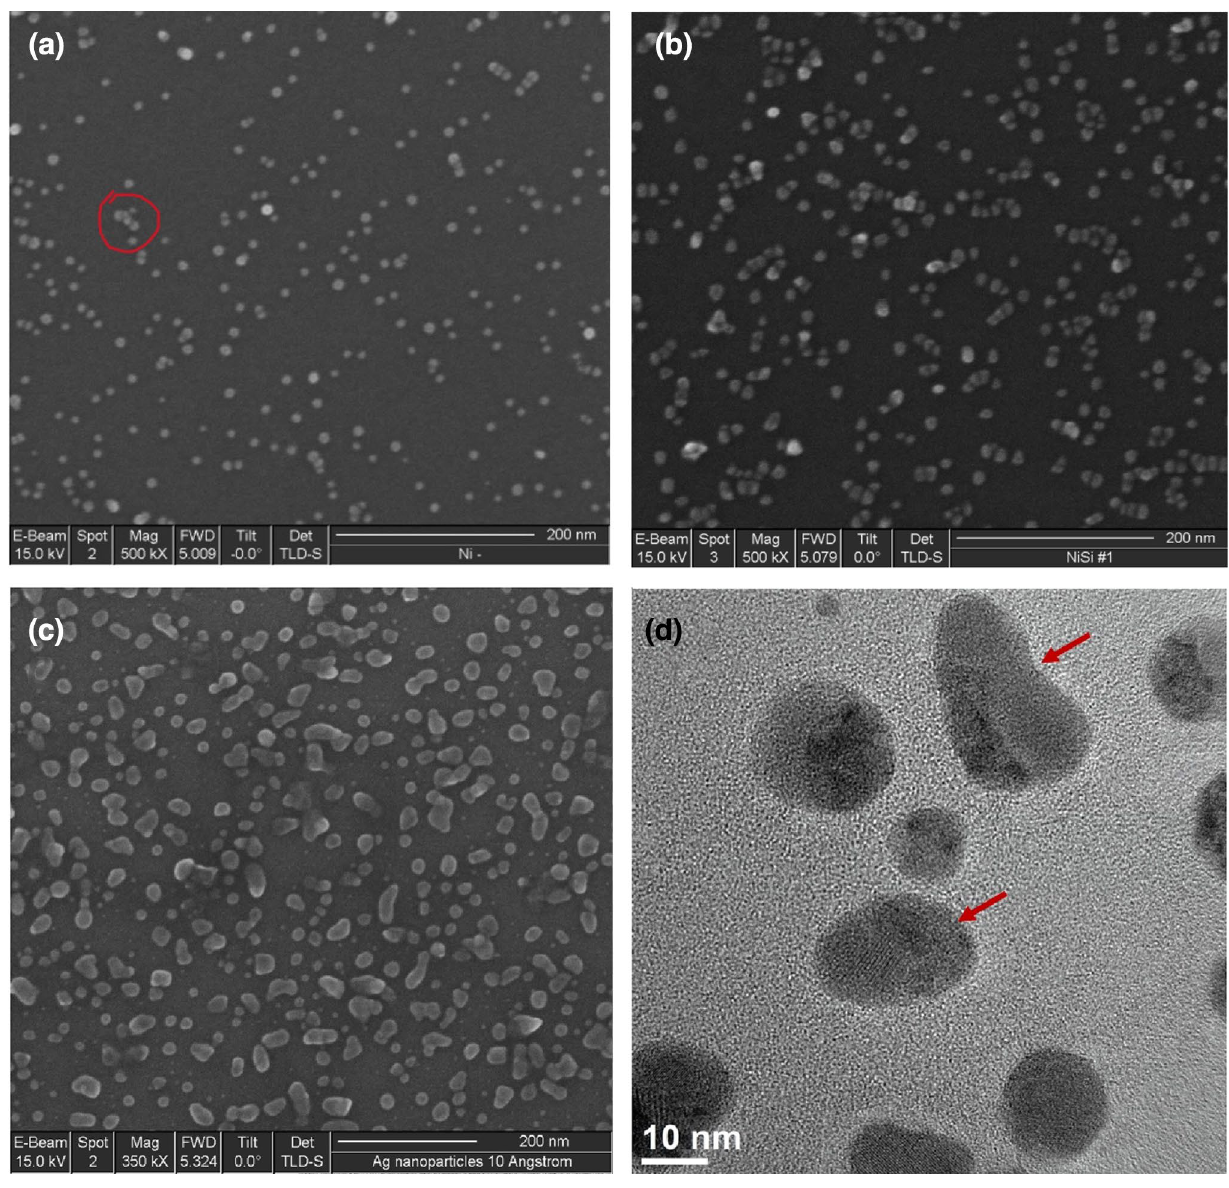
Fig. 1 a SEM image of Ni NPs deposited on Si-SiO . Fractional coverage C = 7%. b same as ( a ), with C = 14%. c SEM image of Ag NPs depos- x ited on Si-SiO , C = 30%. d TEM image of Ag NPs, showing agglomerates, as indicated by red x